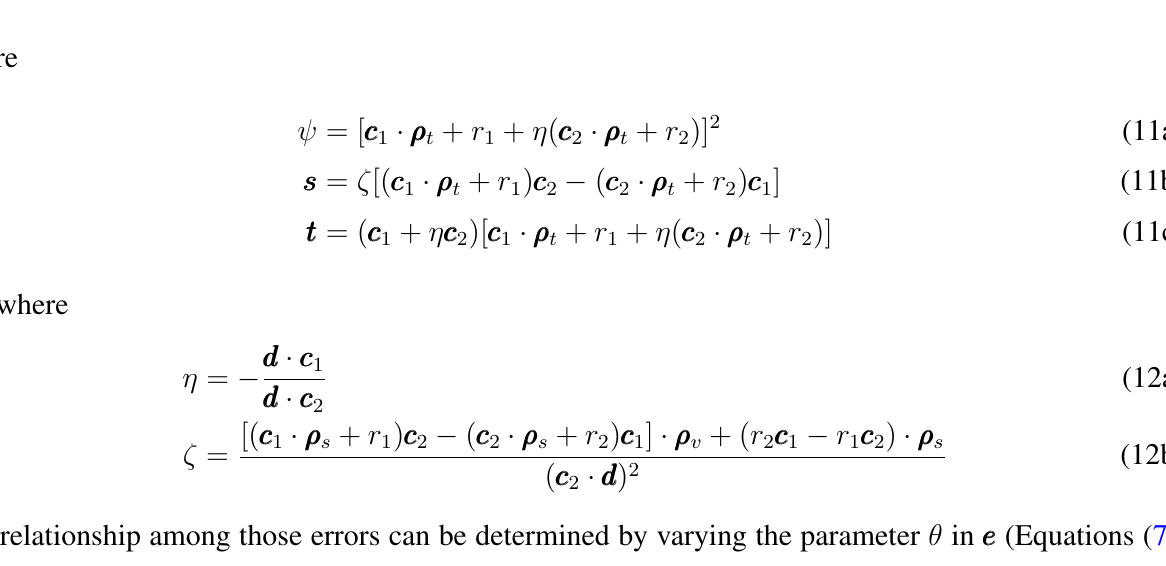
, and (cid:15) , determined by numerical 1 2